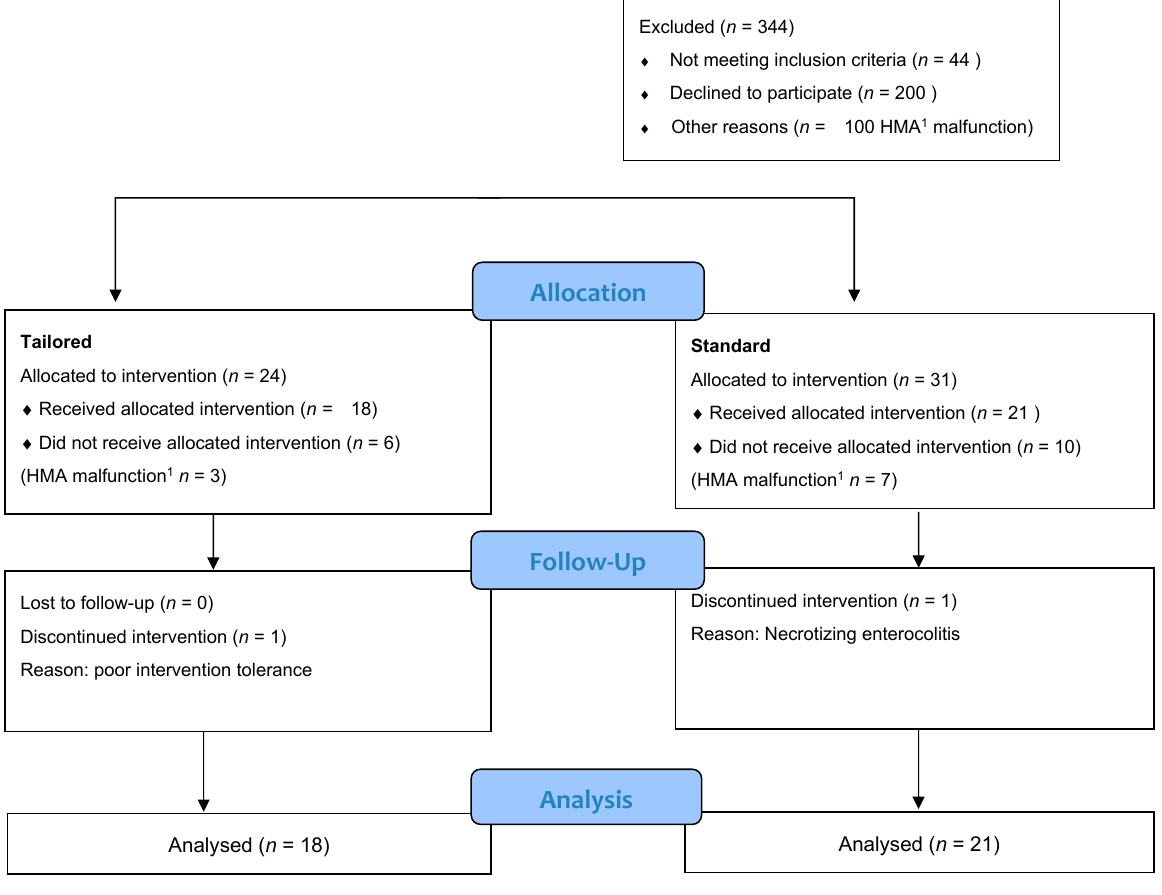
Figure 1. Participant enrollment